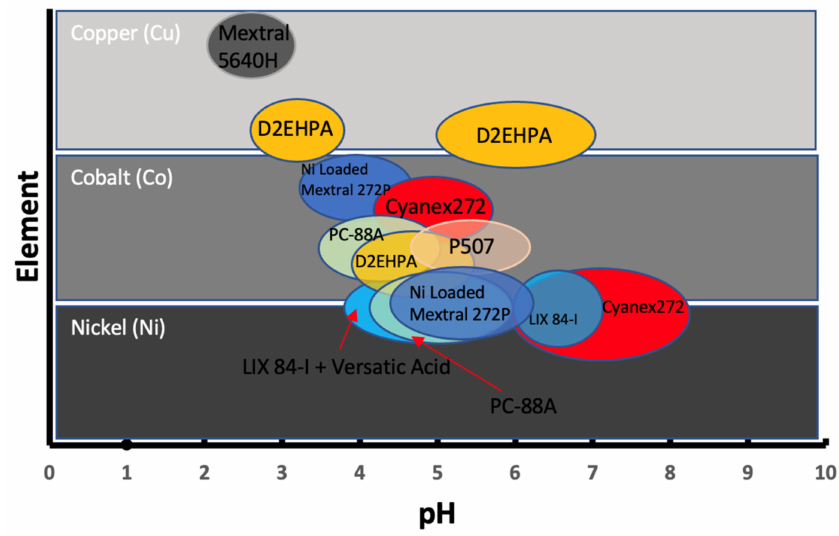
Figure 13. Effect of pH on the solvent extraction of Cu, Ni and Co using different extraction reagents (at 25 ◦ C and A:O = 1, except for Mextral 5640H (A:O = 2)) (Data derived from refs.